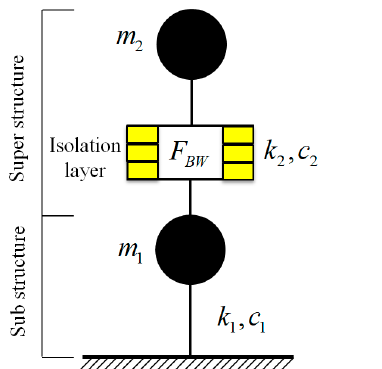
Figure 3. Simplified analysis model of the isolation system. ( a ) Simplified model; ( b ) Analysis